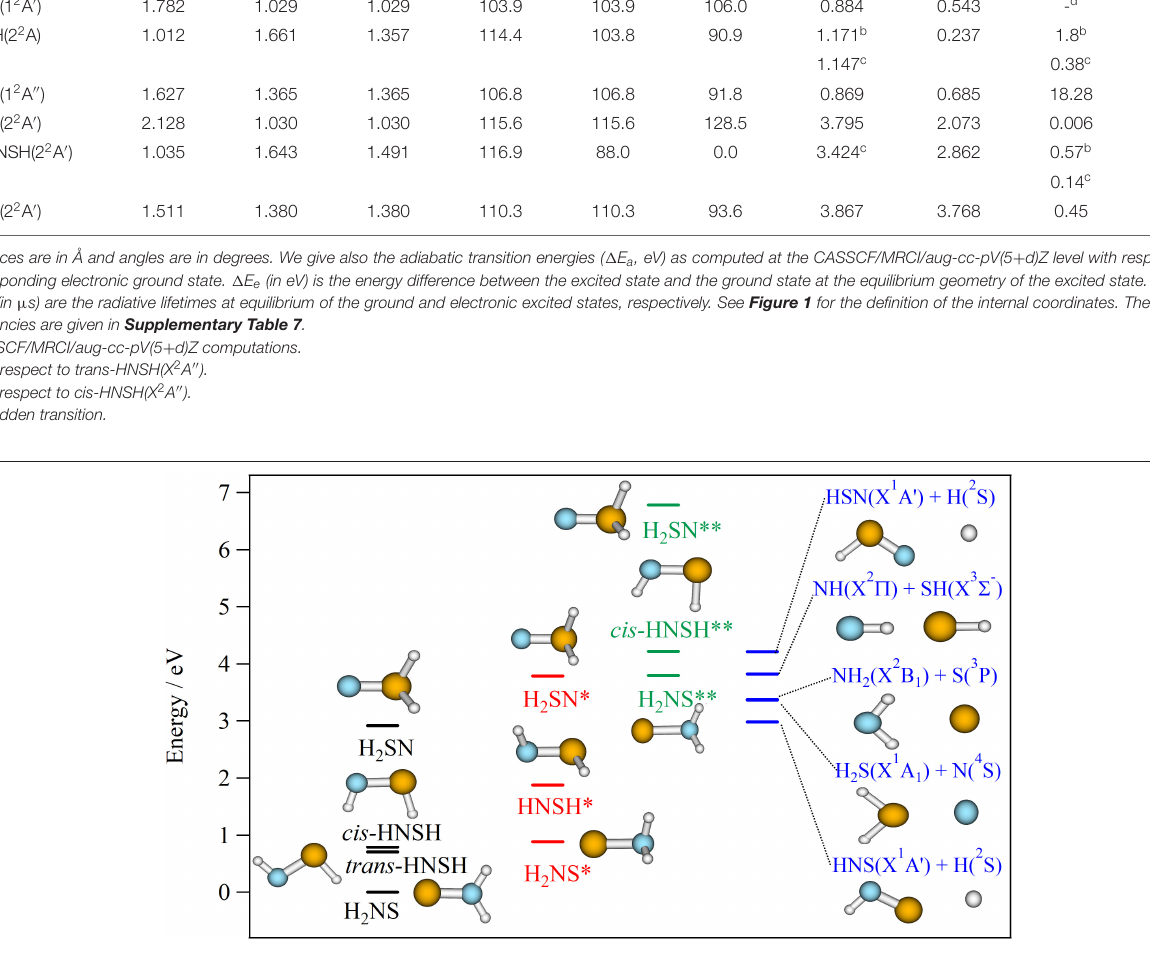
FIGURE 7 | (R)CCSD(T)/CBS fragmentation energies (in eV) of H 2 NS, trans- HNSH, cis- HNSH and H 2 SN forming HNS/HSN + H; NH 2 + S, H 2 S + N and NH 2 + SH. These energies are given with respect to the H 2 NS ground state at equilibrium. Molecular species denoted by * and ** are electronically excited species in the first and second excited states, respectively ( Table 3 ). All molecular species are taken at their equilibrium structure as optimized at the respective theoretical level. The ZPE correction is also included. See Supplementary Tables 8 , 9 for more